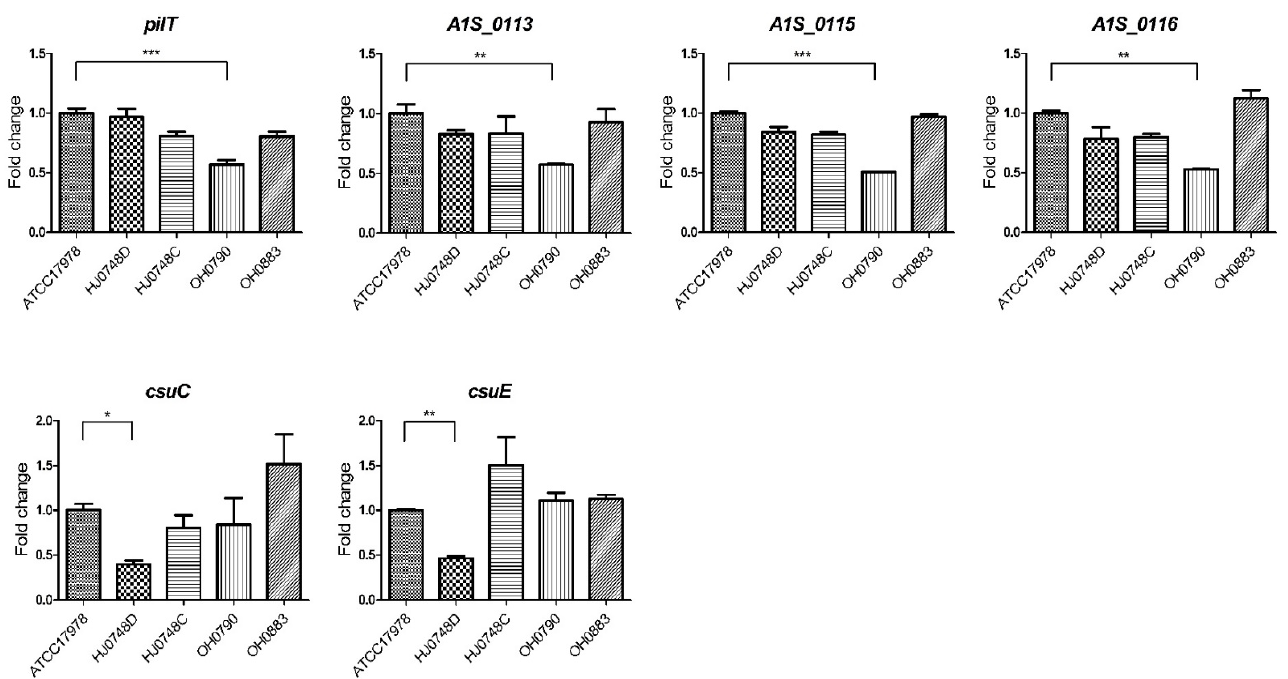
Figure 3. Expression of surface motility- and biofilm-associated genes in Δ b fmR and Δ b fmS mutant strains. A. baumannii ATCC 17,978 (wild-type), HJ0748D ( Δ bfmR mutant), HJ0748C ( bfmR -complemented strain), OH0790 ( Δ bfmS mutant), and OH0883 ( bfmS -complemented strain) were grown in MH medium to an OD 600 of 2.0 and the total RNA was extracted. qPCR was performed to determine the transcription level of genes. The data are the mean ± SEM expression levels of genes in each strain relative to the expression of these genes in ATCC 17978. The data are presented as the mean ± SEM of three independent experiments. * p < 0.05, ** p < 0.01, *** p < 0.001 compared to the WT strain.